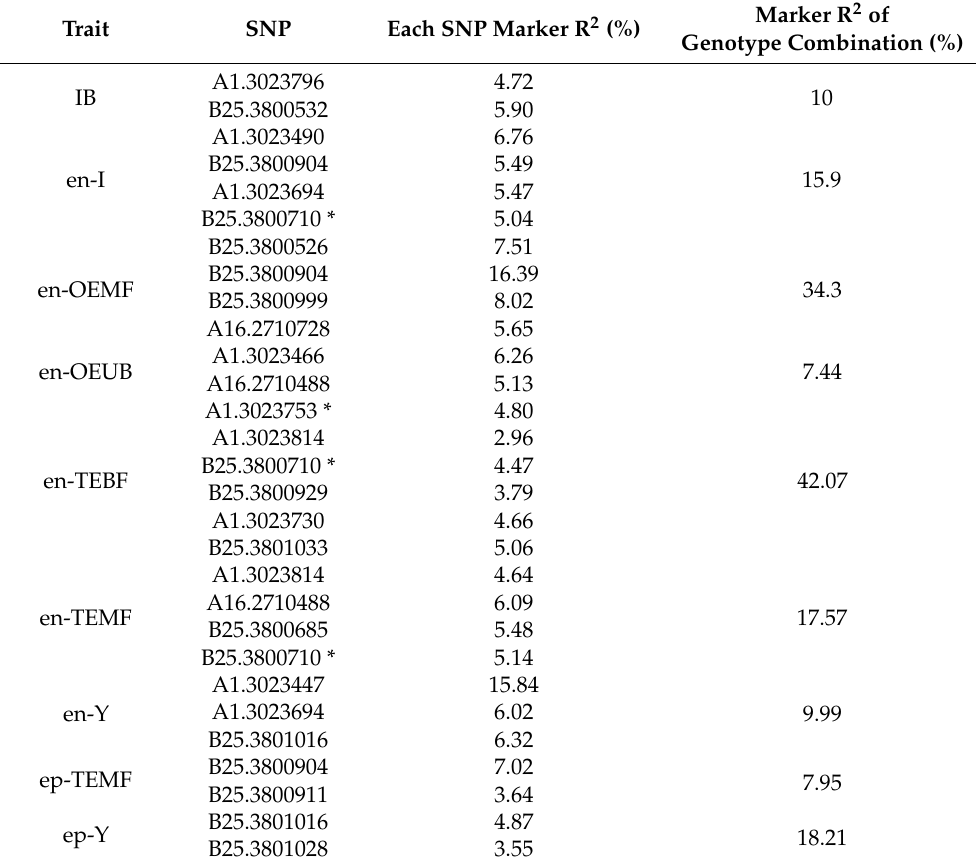
Table 4. The explained percentage of PV of each type of IBs by genotype combination. Trait